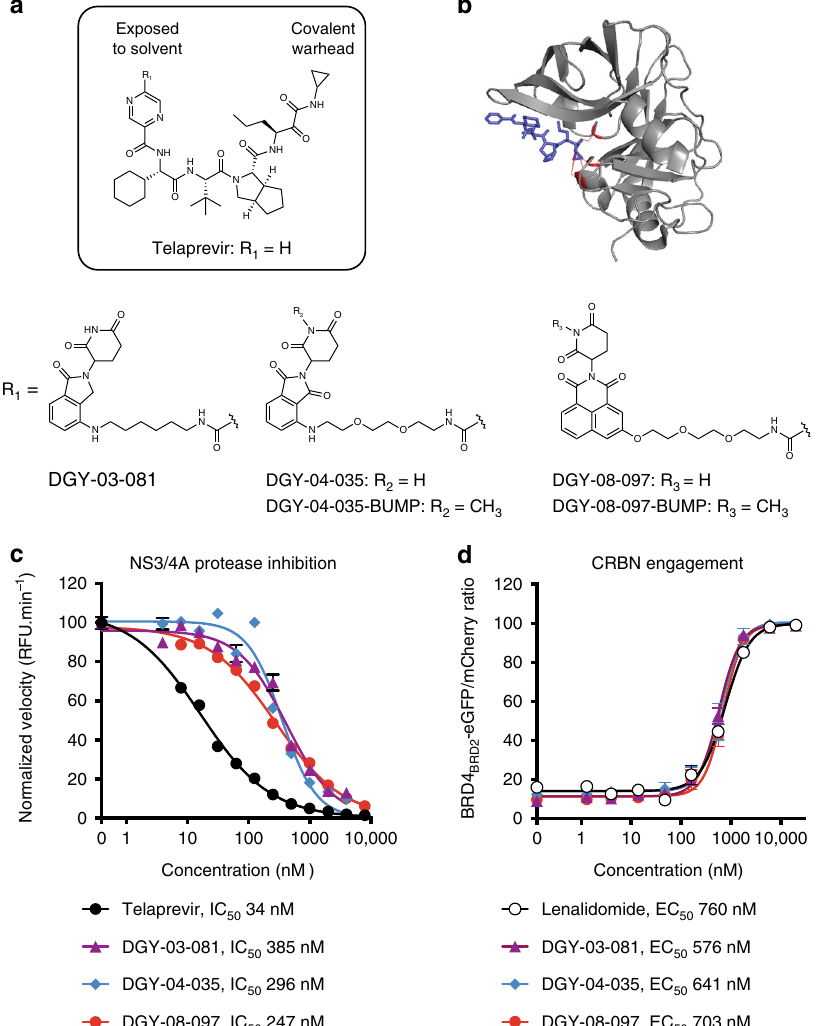
Fig. 1 Design and biochemical characterization of the NS3-targeting degraders a Chemical structures of telaprevir and the degrader derivatives DGY-03- 081, DGY-04-035, and DGY-08-097 where R 1 is the CRBN ligand. DGY-04-035-BUMP and DGY-08-097-BUMP are negative control analogs due to methylation of the glutarimide, as this modi fi cation has previously been shown to ablate CRBN-binding 11 . b Crystal structure of telaprevir bound to the HCV NS3/4A protease complex (PDB 3SV6). Telaprevir is shown in blue and the protease catalytic triad is shown in red. c Measurement of NS3/4A protease inhibition in vitro. Cell lysates containing the endogenous NS3/4A protease were prepared from cells stably expressing an HCV subgenomic replicon. These were incubated with candidate degraders at the indicated concentrations followed by addition of an HCV NS3 FRET peptide substrate. Cleavage of the FRET substrate was measured for 1 h at 30 °C, and the rate of enzymatic cleavage was fi tted by linear regression. The concentration that led to a 50% decrease in HCV NS3/4A enzymatic activity (IC 50 ) was determined by nonlinear regression. Data are presented as means normalized to DMSO ± standard deviation of n = 2 technical replicates. One representative experiment is shown, with IC 50 values averaged from n ≥ 3 independent experiments. Source data are provided as a Source Data fi le. RFU: relative fl uorescence units. d Quantitative assessment of intracellular CRBN engagement using a BRD4 BRD2